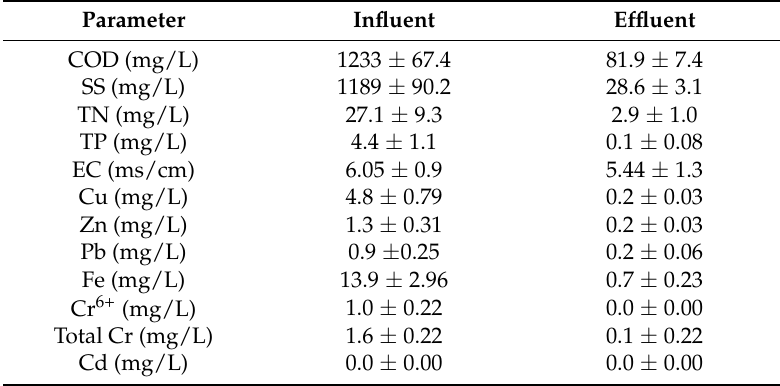
Table 1. Influent and effluent water characterization of KOIZ WWTP.